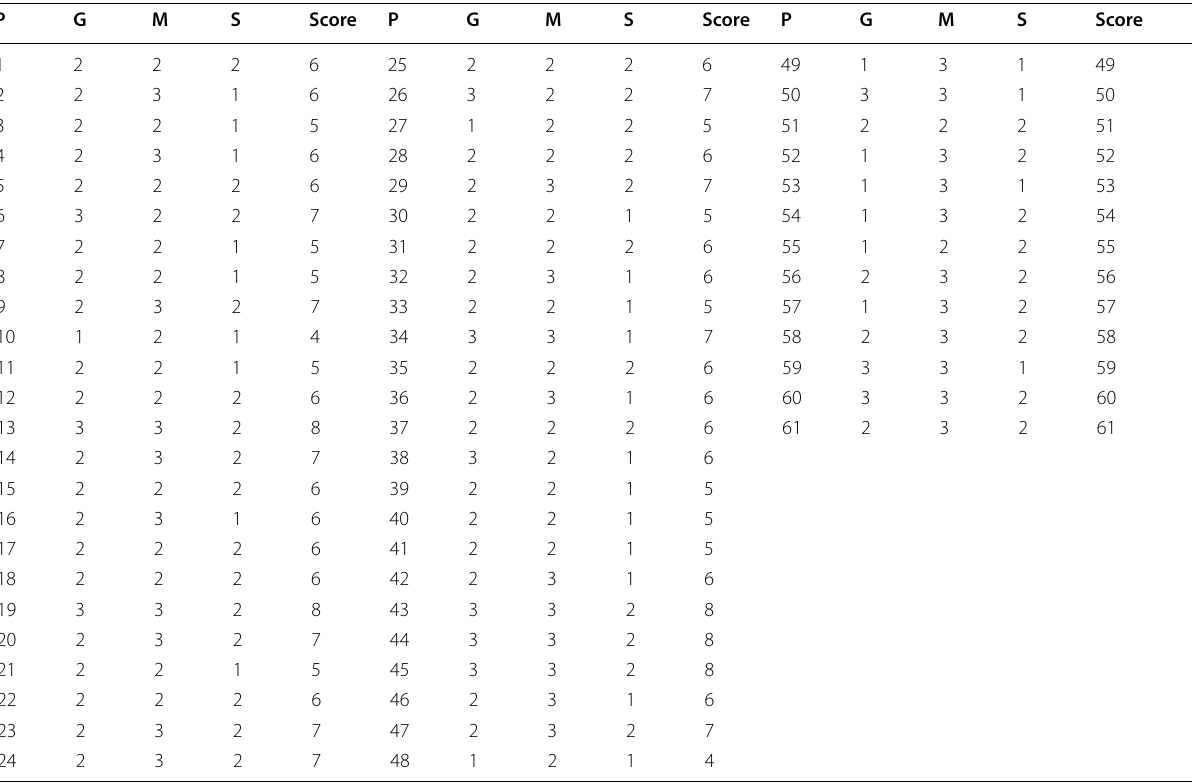
Table 5 GMS Score for each patient